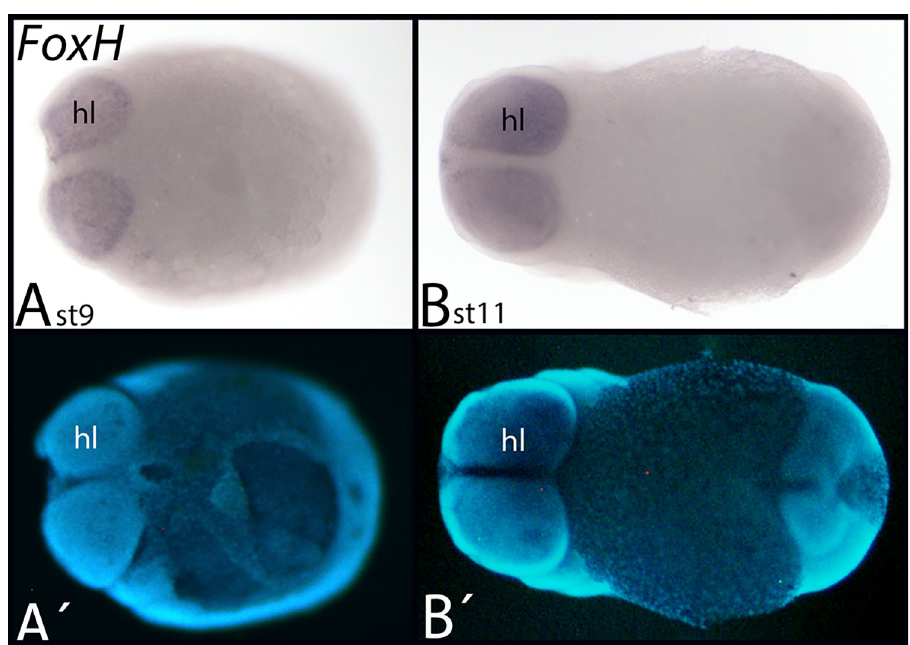
Fig 12. Expression of Euperipatoides FoxH . In all panels, anterior is to the left, ventral views. A´/B´ represent DAPI staining of the embryos shown in A/B Abbreviations in Table 2.